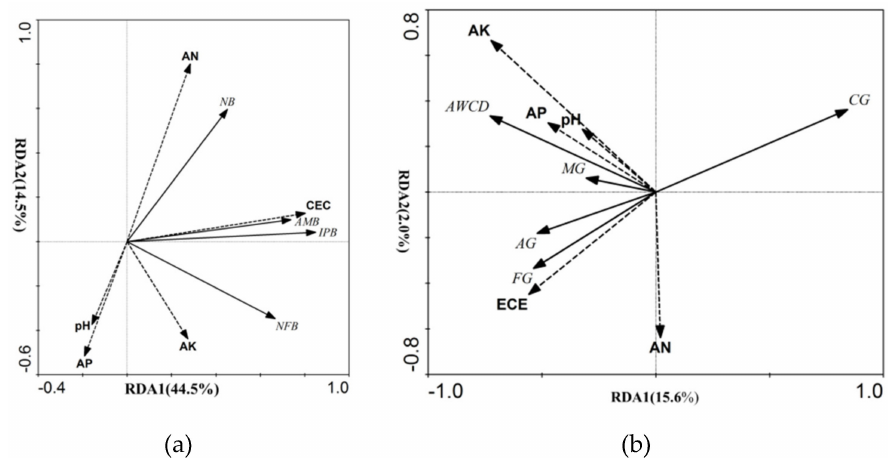
Figure 8. RDA analysis of microbial quantities and soil properties ( a ) and metabolic profiles and soil properties ( b ). NFB, quantities of nitrogen-fixing bacteria; AMB, ammonifying bacteria; IPB, inorganic phosphorus-solubilizing bacteria; NB, nitrosobacteria; CEC, cation exchange capacity; SOC, organic carbon; AN, available nitrogen; AP, available phosphorus; AK, available potassium. CG, carbohydrates and their derivatives; AG, amino acids and their derivatives; FG, fatty acids and lipids; MG,